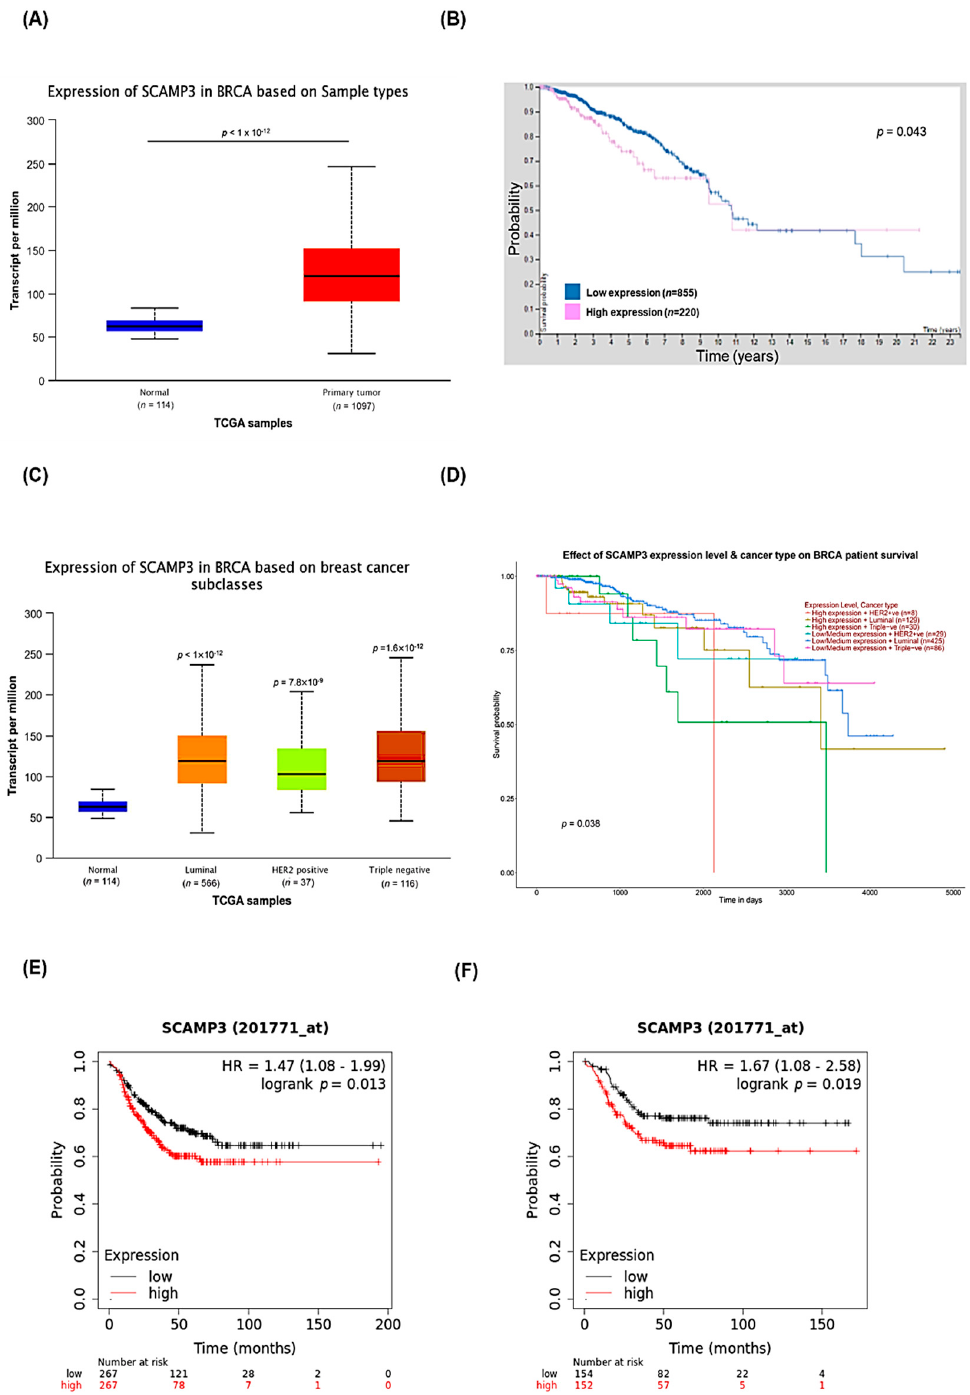
Figure 7. SCAMP3 expression analyses from the TCGA database. ( A ) UALCAN portal analysis comparing SCAMP3 expression between normal and breast cancer tumors. ( B ) Probability of survival between breast cancer patients with high and low SCAMP3 expression using The Human Protein Atlas portal. ( C ) Expression of SCAMP3 in different subtypes of breast cancer. ( D ) Probability of survival between breast cancer patients with different subtypes and low to high levels of SCAMP3 expression. Green line = SCAMP3 high expression (TNBC). ( E ) Probability of relapse-free survival (RFS) between TNBC patients with high and low SCAMP3 expression using Kaplan–Meier Plotter portal. ( F ) Probability of distant metastasis ‐ free survival (DMFS) between patients with TNBC with high and low SCAMP3 expression using Kaplan–Meier Plotter portal.